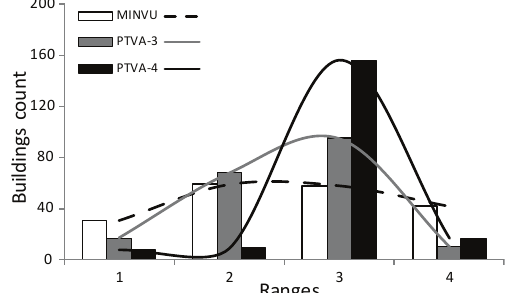
Figure 7. Number of buildings in the different established